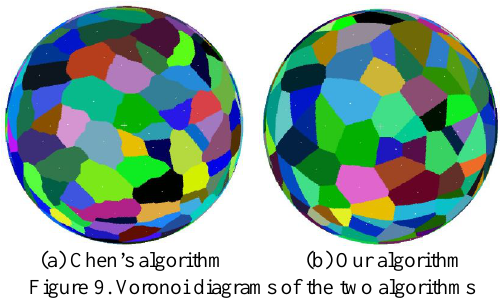
Figure 9. Voronoi diagrams of the two algorithms